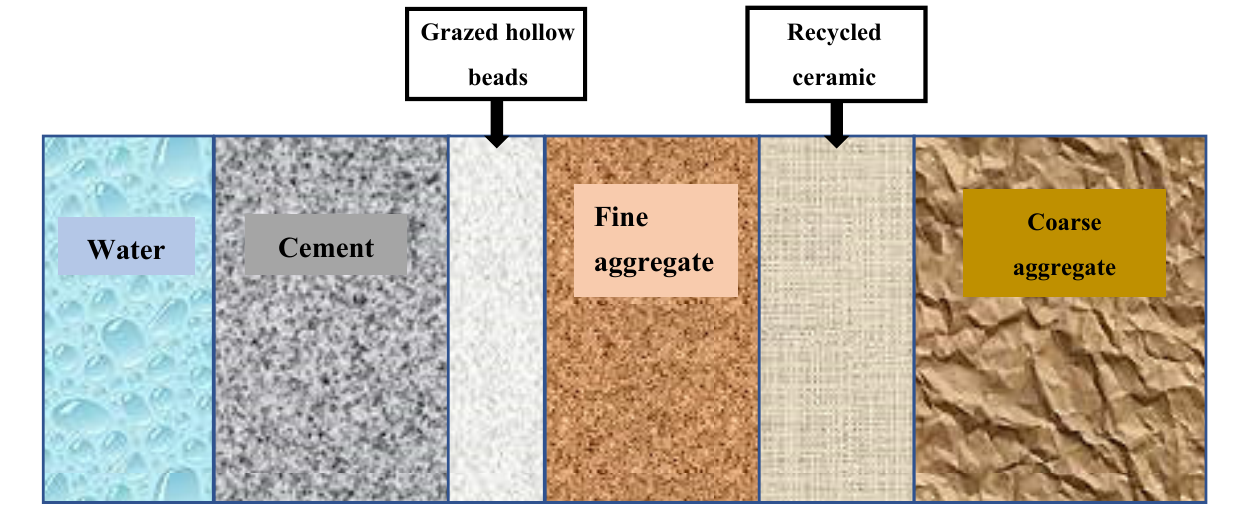
Figure 2. The particle size distribution curves of nature stone.